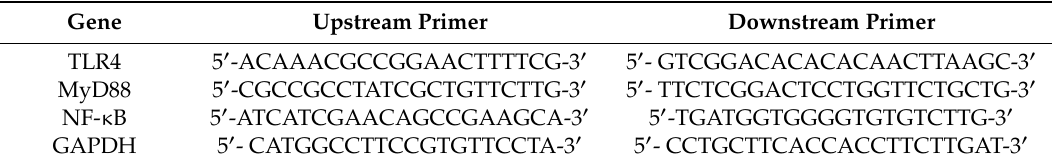
Table 1. The primer sequences of gene.